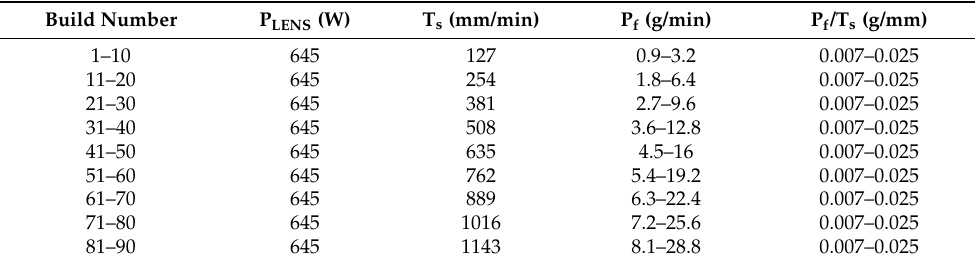
Table 1. Distribution of basic parameters in the 90-bead